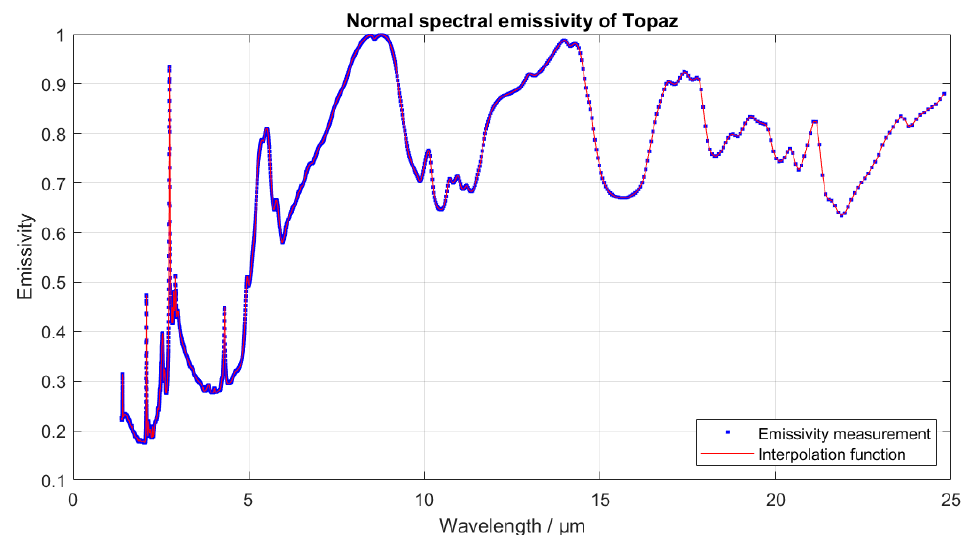
Figure 3. Example of normal spectral emissivity of Topaz (sample from site 3) from USGS Spectral Library [27].